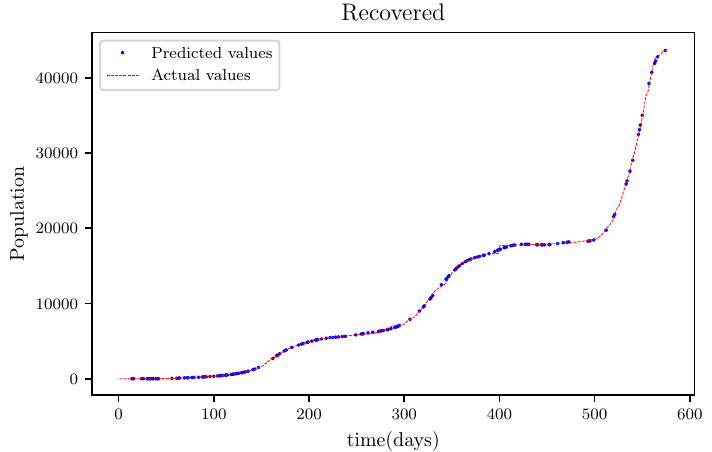
Figure 16. The graph shows a comparison of the predicted infected population values and the actual data of the infected population for a 530 data points.